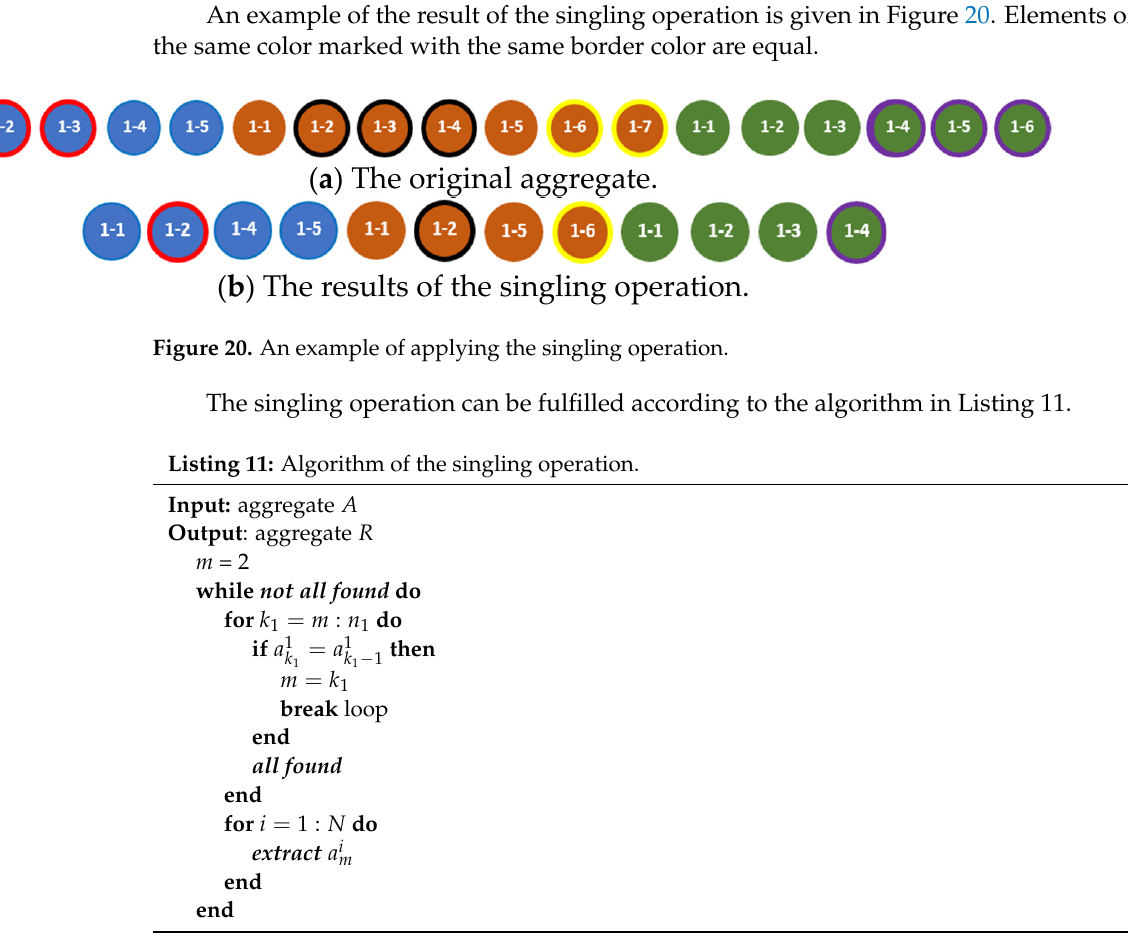
Figure 1. An example of two compatible